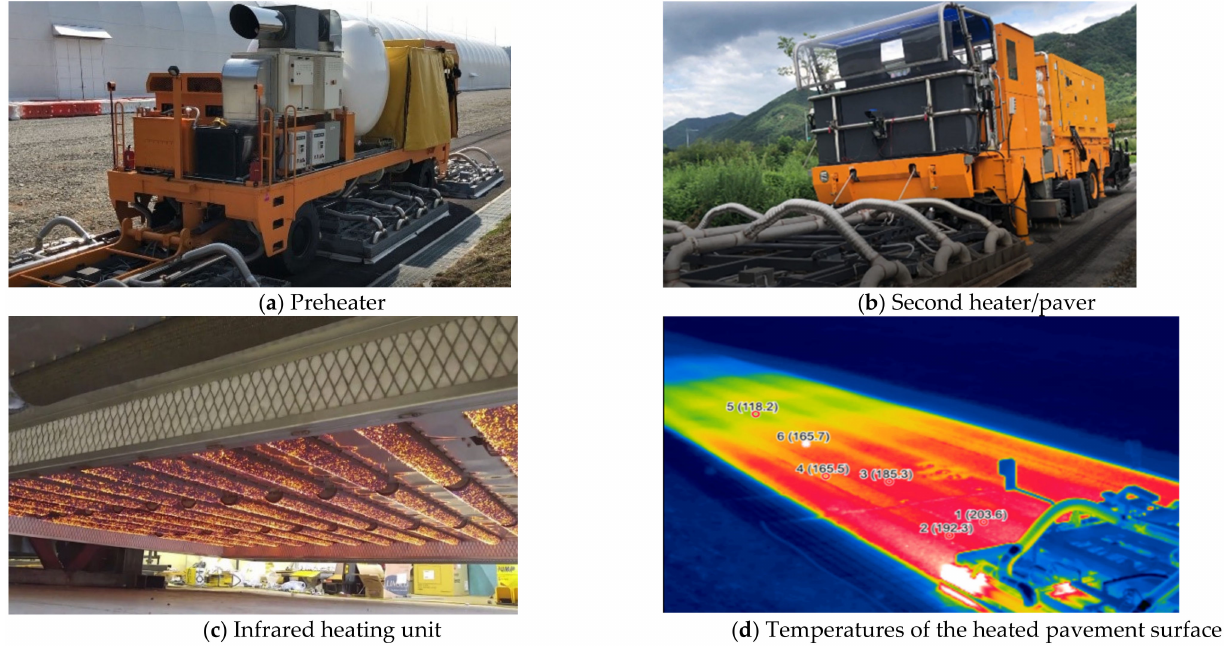
Figure 1. New WIR equipment and temperature of pavement surface after heating.